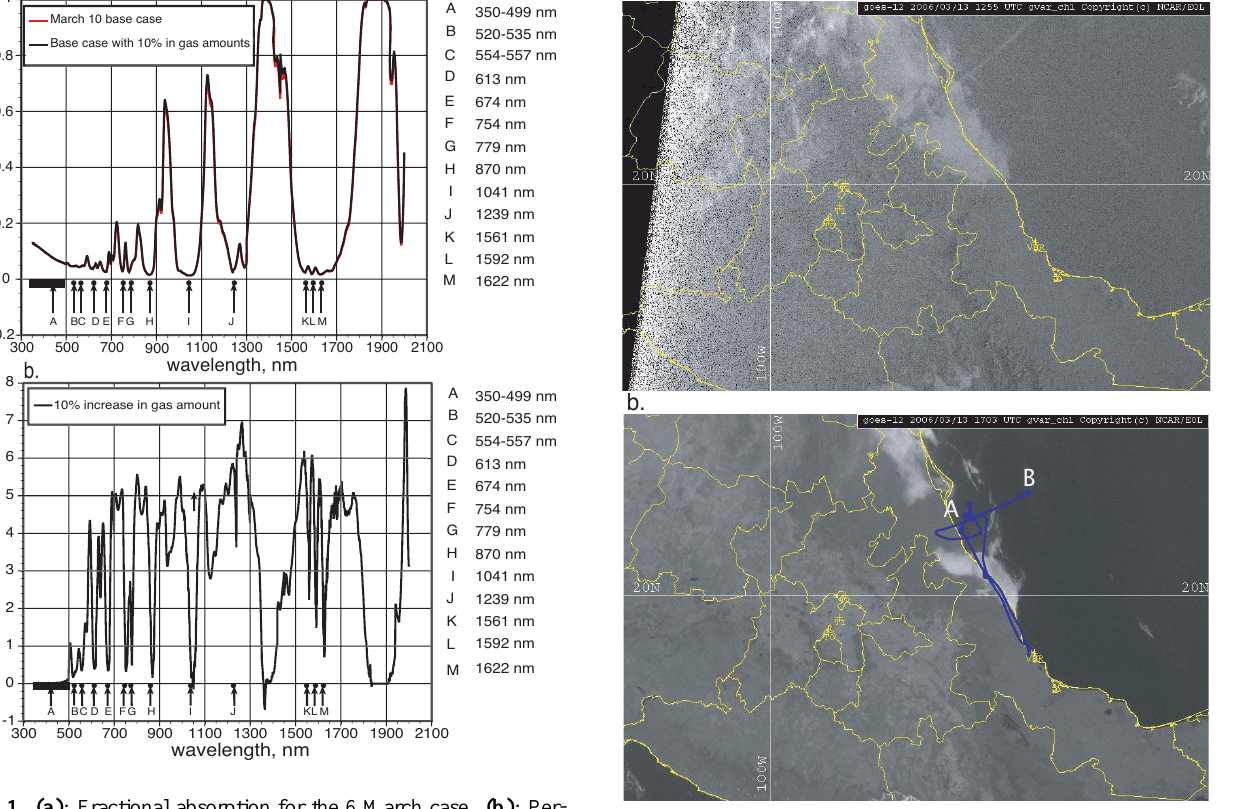
Fig. 2. (a) : GOES 16 satellite image on 13 March 2006 at 12:55 UTC. (b) : GOES 16 satellite image on 13 March 2006 at 17:03UTC. Letter A shows the location of the start of the plane leg. Letter B shows the location of the end of the plane